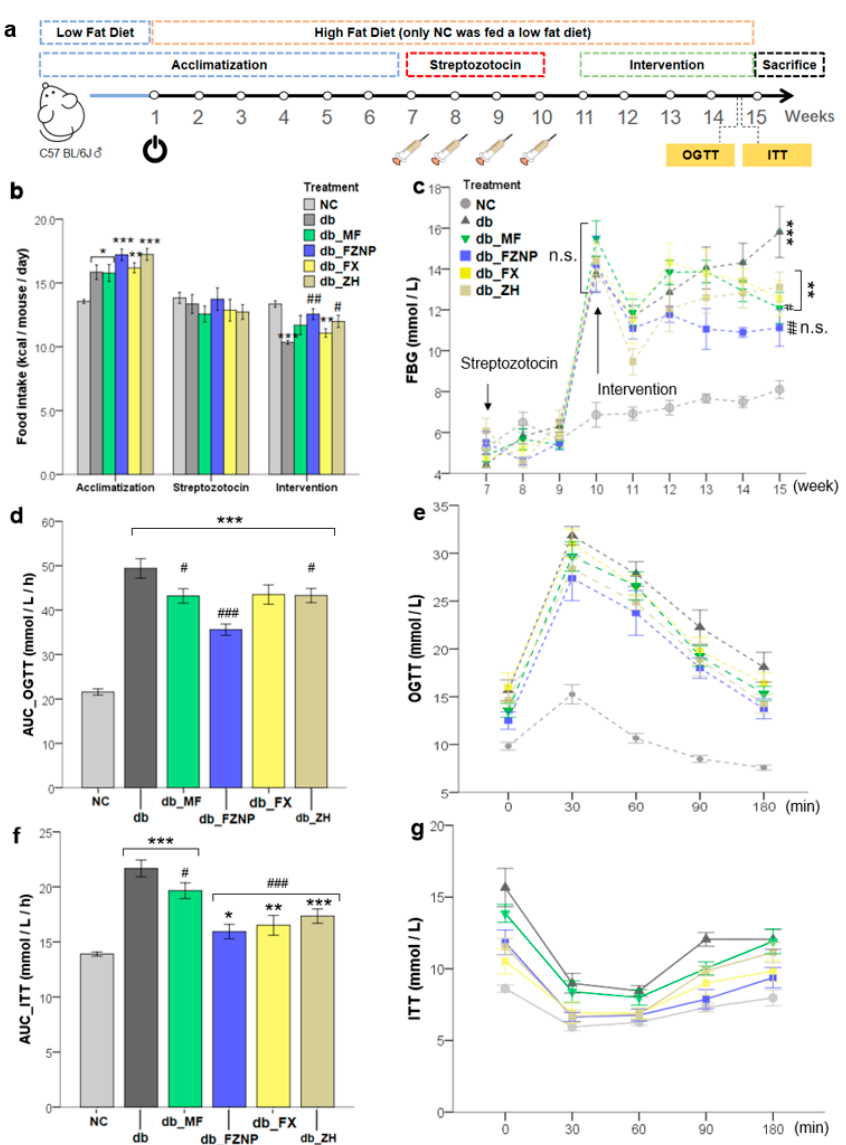
Figure 2. The schedule of mice experiments during 15 weeks ( a ), daily food intake ( b ), fasting blood glucose testing in mice (FBG, c ), oral glucose tolerance (OGTT, e ) and insulin tolerance (ITT, g ) and the area under the curve of glucose (AUC_OGTT, d ) and insulin (AUC_ITT, f ). The asterisk including * ( p < 0.05), ** ( p ≤ 0.01), and *** ( p ≤ 0.001) indicate the significant difference compared with the NC group. The hashes including # ( p < 0.05), ## ( p ≤ 0.01) and ### ( p ≤ 0.001) indicate the significant difference from the db